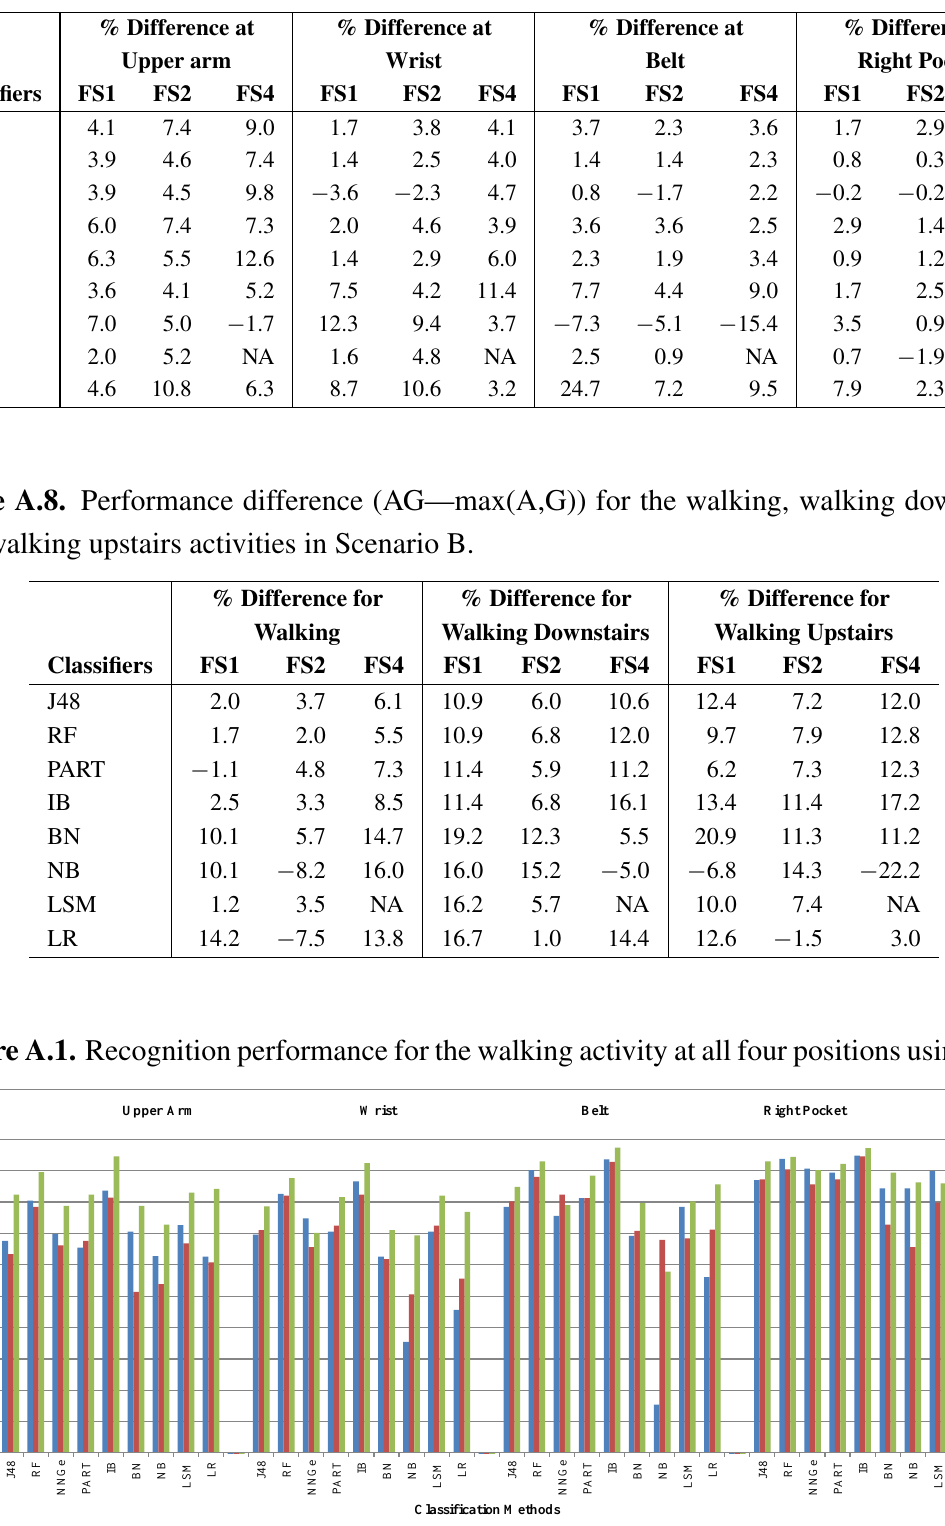
Table A.7. Performance difference (AG—max(A,G)) for the walking activity in Scenario A. % Difference at % Difference at % Difference at % Difference at Upper arm Wrist Belt Right Pocket Classifiers J48